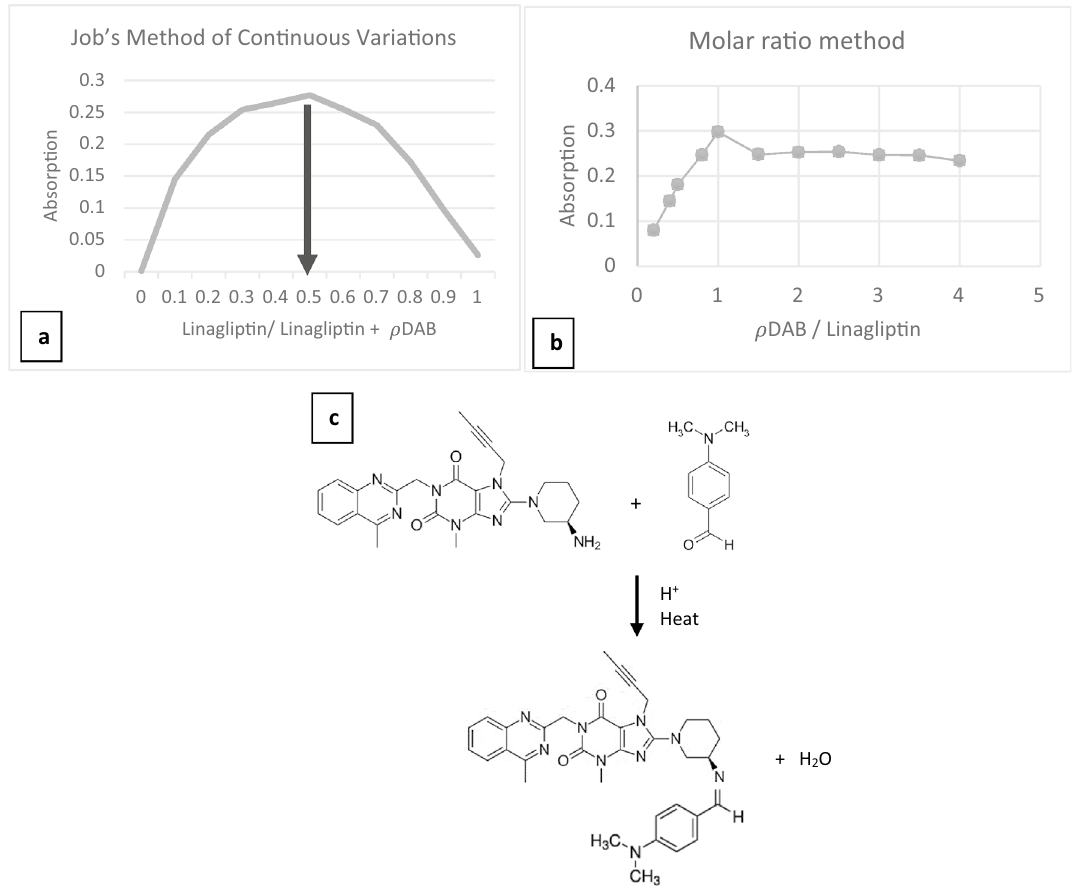
Figure 4. Stoichiometry of reaction LNG and PDAB. ( a ) Job’s method of continuous variations between LNG and PDAB. [LNG]: 2 × 10 −3 M; [PDAB]: 2 × 10 −3 M; [LNG] + [PDAB]: 4 mL + [HCl]: 2 mL. ( b ) Molar ratio method of stichometry of the reaction between LNG and PDAB. ( c ): Proposed reaction pathway between LNG and